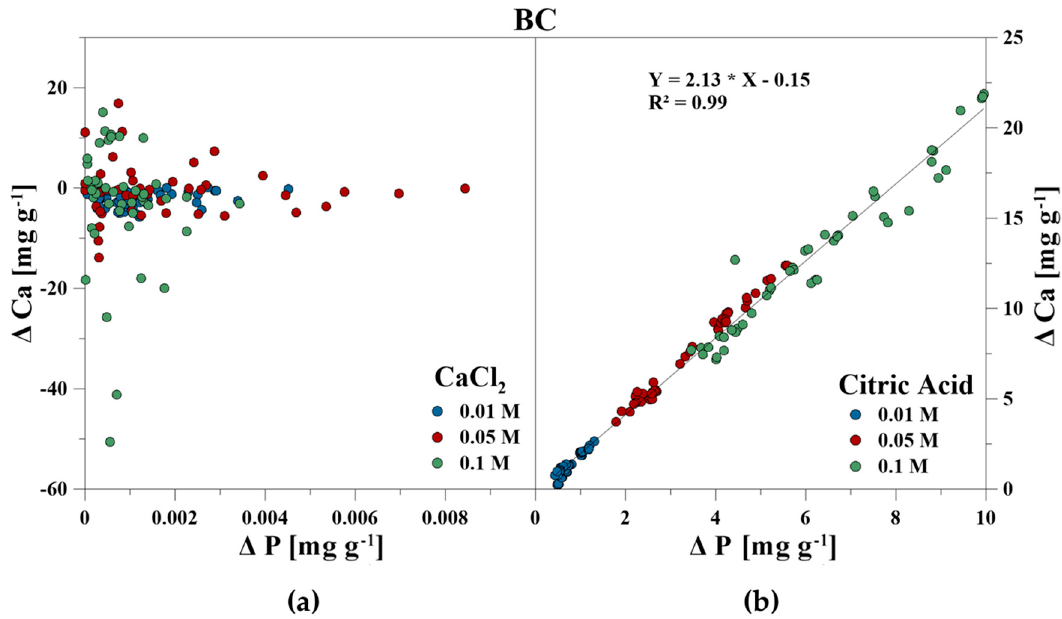
Figure 5. Correlation between dissolved P and Ca during P release using ( a ) CaCl 2 and ( b ) CA from bone char.